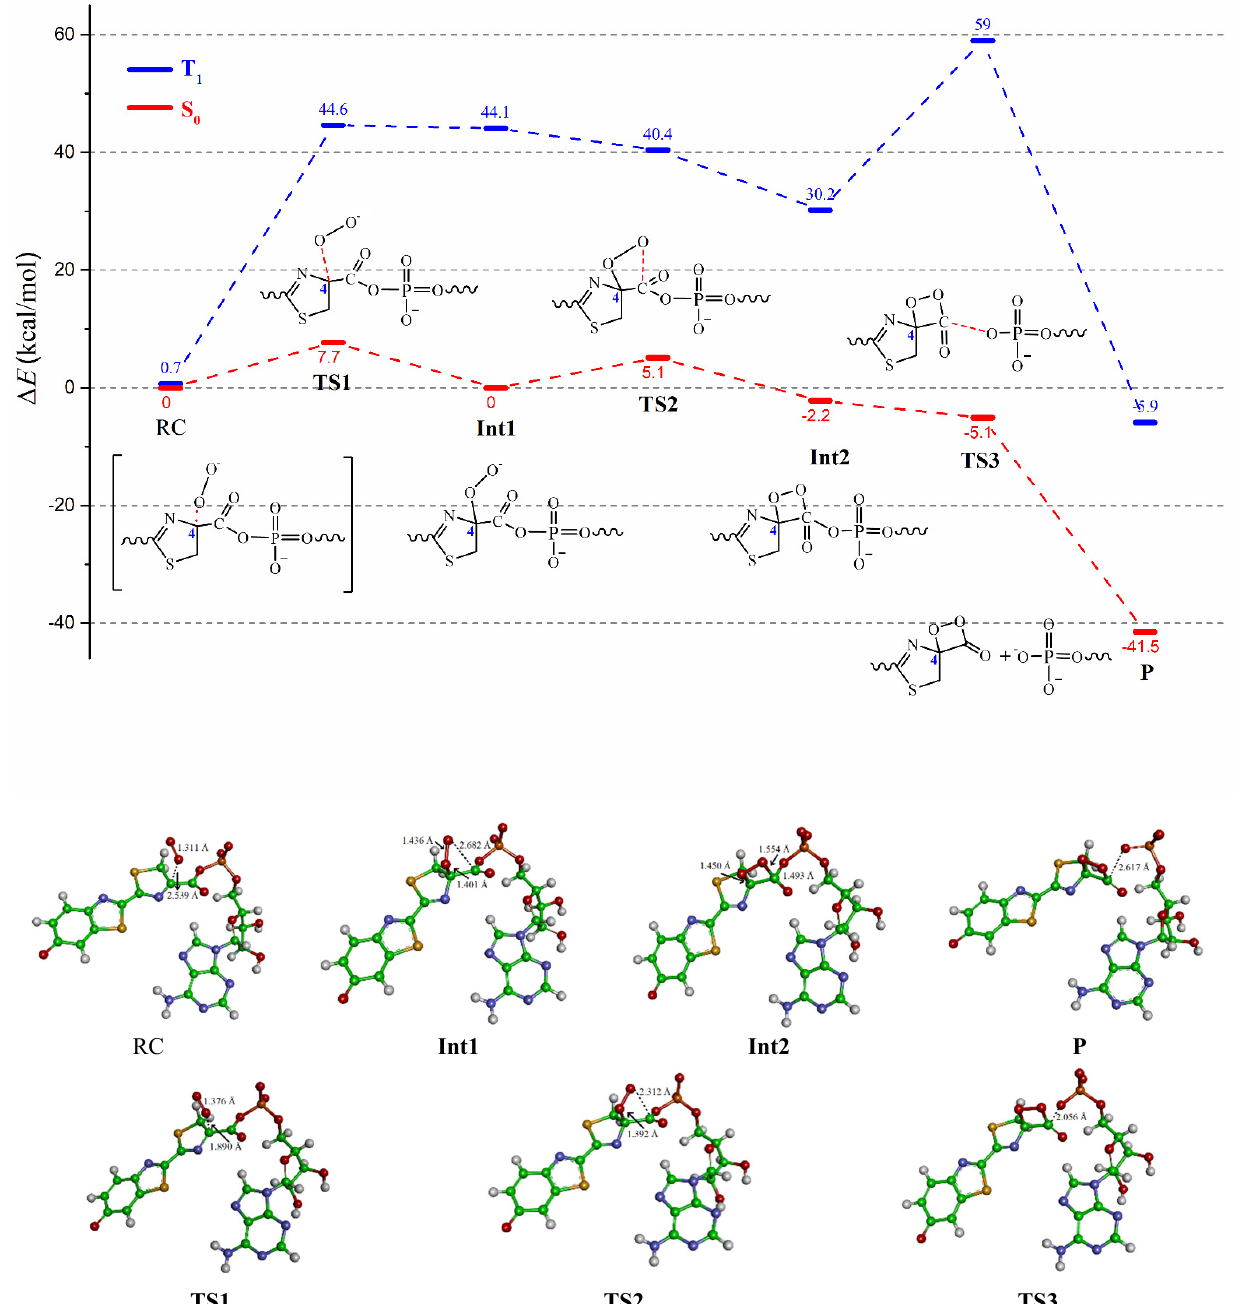
Figure 3. The S 0 and T 1 relative energy profile of the stationary points for oxygenation of L 3 − in protein by ONIOM (UM06-2X/MM) method. (The unit of energies is kcal mol − 1 ) Here and in later figures, carbon atoms are shown in green, oxygen in red, nitrogen in blue, phosphorus in orange and hydrogen in white.